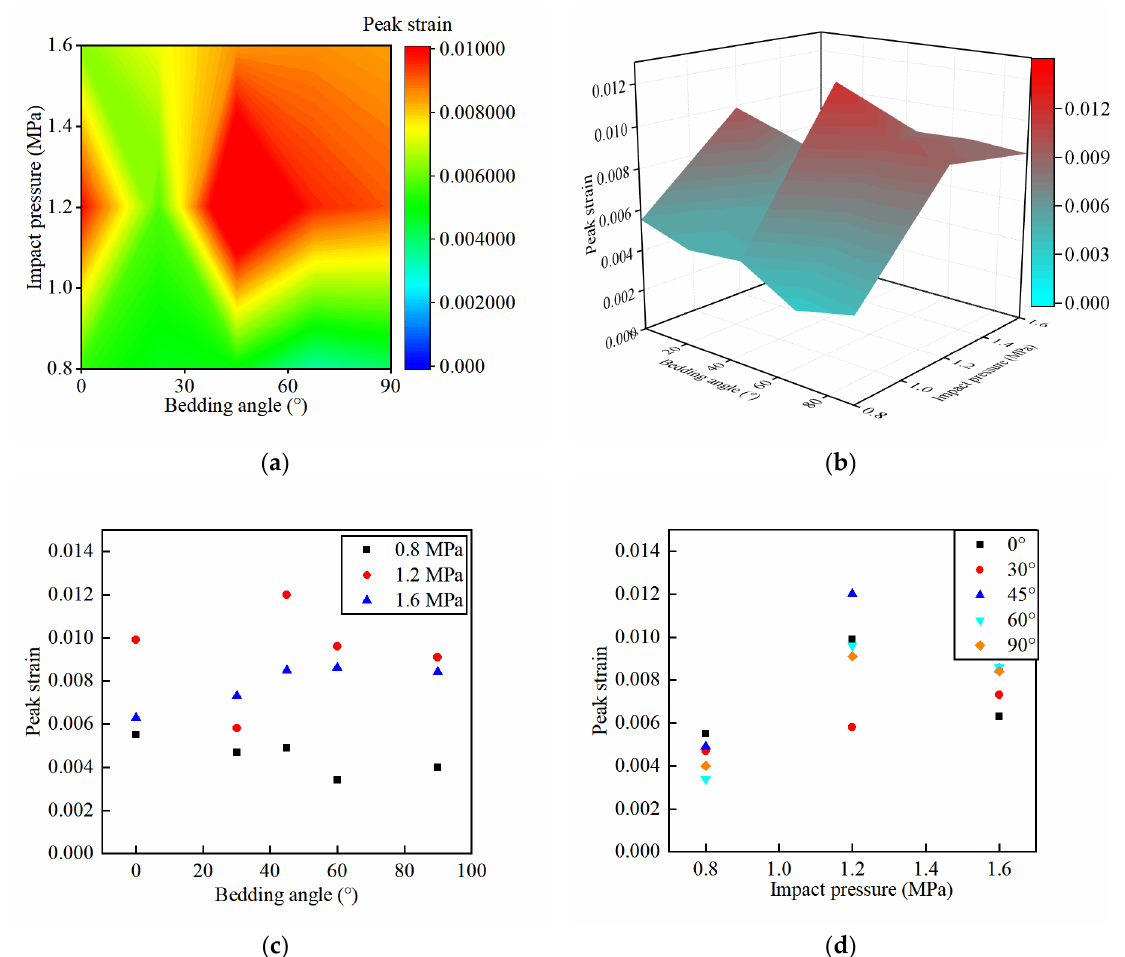
Figure 10. Peak strain of sandstone under different loading conditions. ( a ) Two-dimensional cloud map of peak strain. ( b ) Three-dimensional map of peak strain. ( c ) Different bedding angles. ( d ) Different impact pressure.